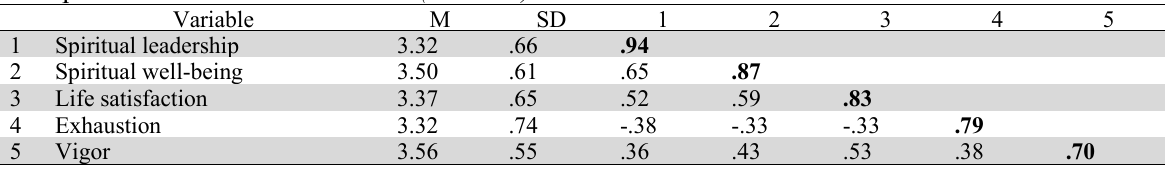
Descriptive statistics and correlations (N = 375